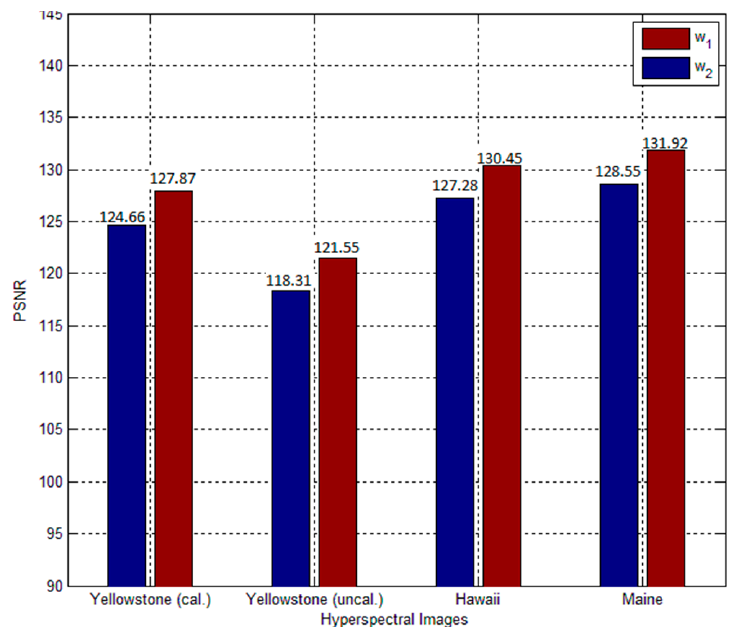
Figure 3. Histogram of the average PSNR achieved for the watermark w 1 and the watermark w 2 (Dataset 2).